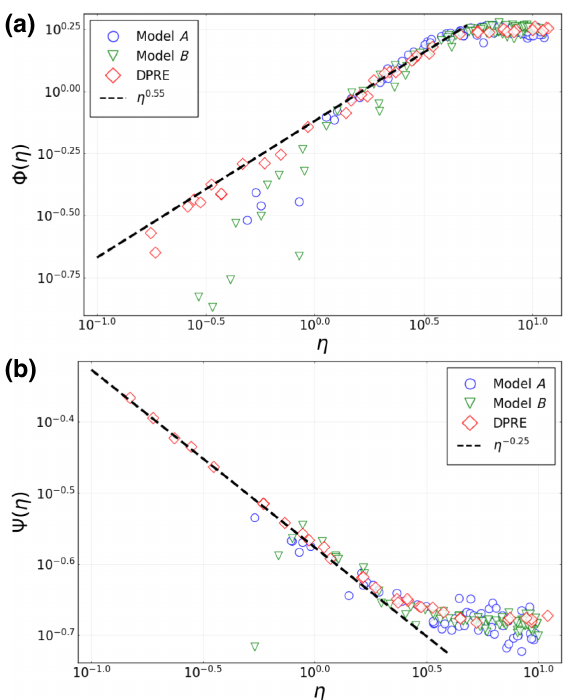
FIG. 17. Universal scaling functions (cid:10)(η) and (cid:12)(η) extracted from models A and B (see text) and compared to those from a DPRE simulation (same data in Figs. 4 and 5). In fitting to Eqs. (19) and (21), we take β = 0.33 and ζ = 0.66 for both models A and B . These plots should be compared with Figs. 4 and